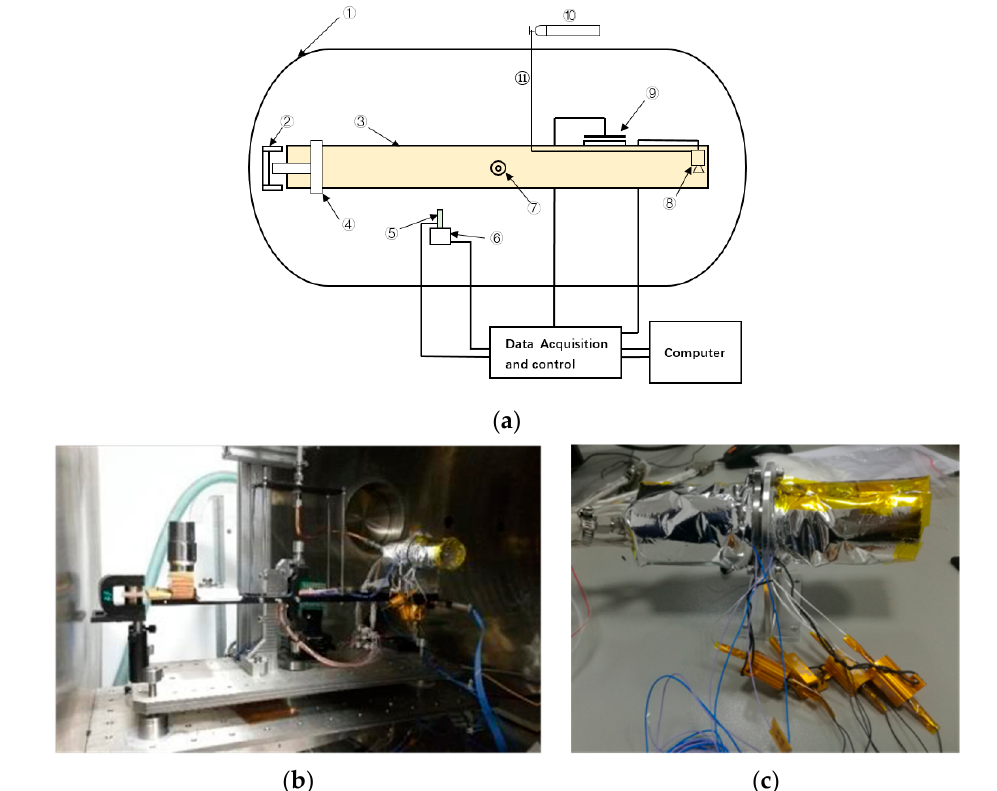
Figure 6. Thrust measurement system. ( a ) Schematic diagram of measuring system. ① Vacuum Chamber; ② Damper; ③ Pendulum; ④ Counter weight; ⑤ Displacement Device; ⑥ Precision Seat; ⑦ Axis; ⑧ Micro ‐ thruster; ⑨ Calibration System; ⑩ Gas Bottle; ⑪ Pipe. ( b ) Establishment of thrust measurement system. ( c ) Thruster with thermal control coating. Table 2. Comparison between experimental and computational thrust results.